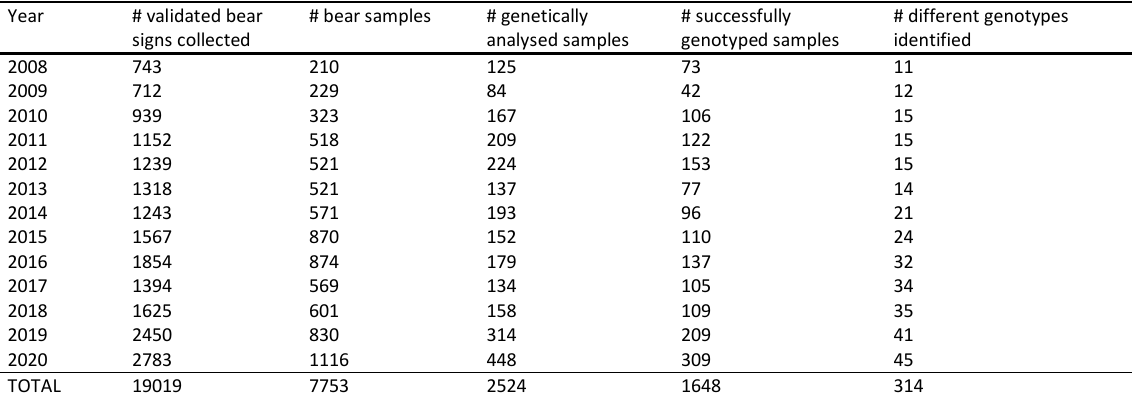
Note: * Estimated based on an average transect length of 10 km. Table S2: Total number of validated non-invasive brown bear signs (e.g., scats, hair, tracks, visual observations, damages, photos / videos) collected in the Pyrenees, total number of validated brown bear samples (i.e. scats and hair) collected in the Pyrenees, number of samples (among collected sampled) genetically analysed by the French molecular laboratory LECA or ANTAGENE, number of brown bear samples (among analysed samples) successfully genotyped and number of different brown bear genotypes identified (among successfully genotyped samples) per year between 2008 and 2020.